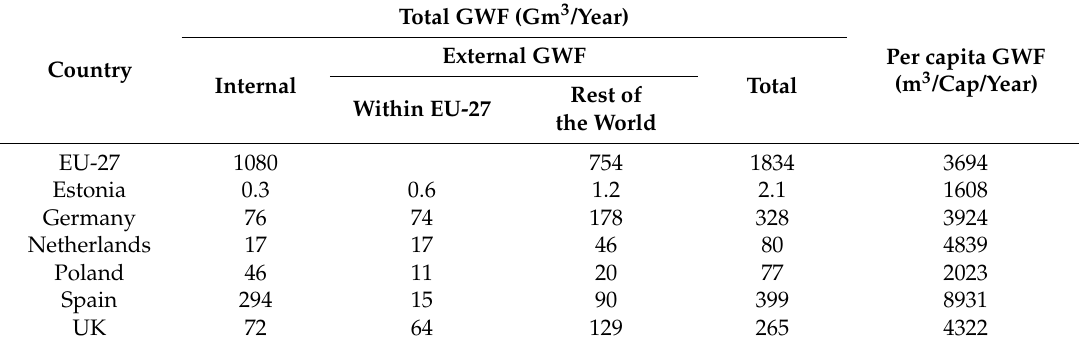
Table 3. Grey water footprint of the EU-27 1 s and some selected countries related to consumption of agricultural products. Period: